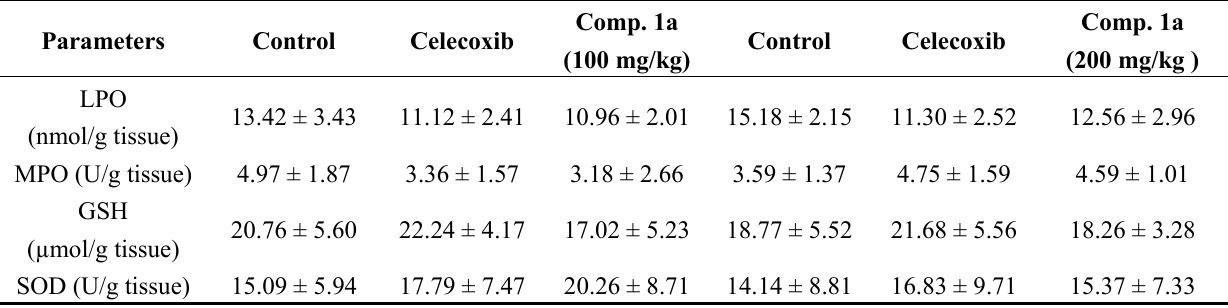
Table 4. Oxidative stress parameters in kidney.